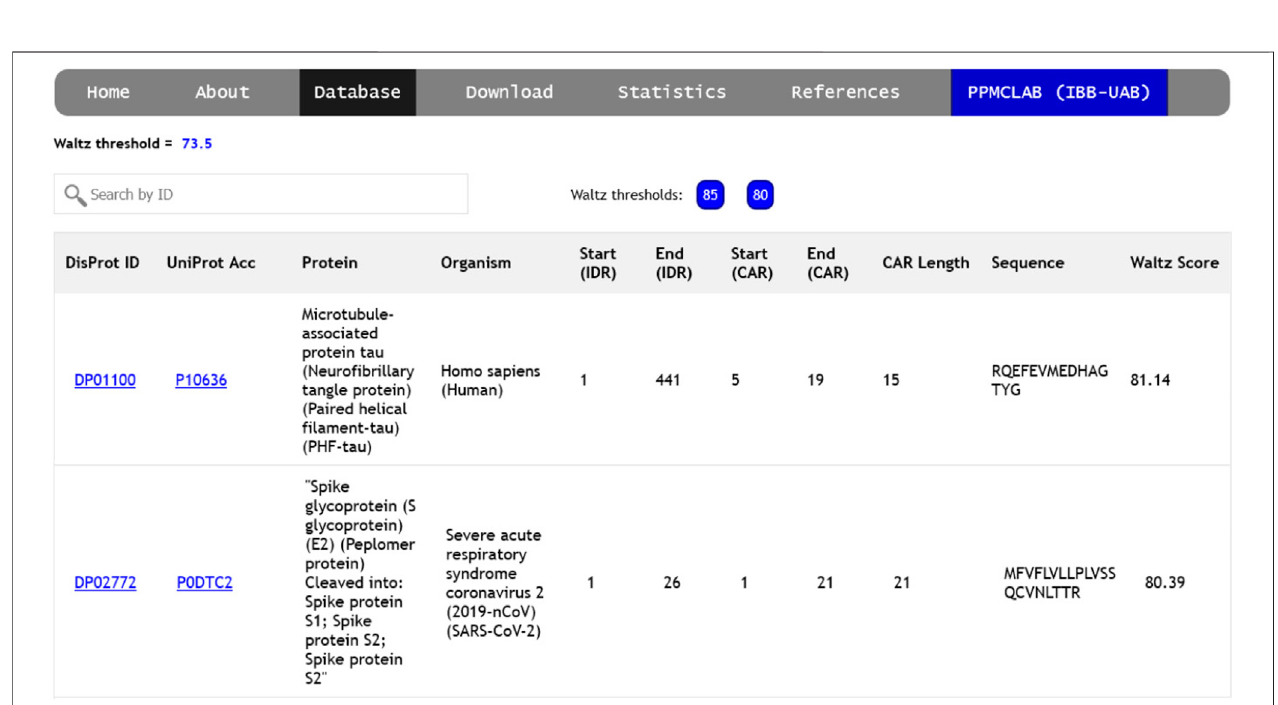
FIGURE2| Screenshotofthe ‘ Database ’ page.Thedifferentthresholds canbeexploredusingthe ‘ 85 ’ , ‘ 80 ’ and ‘ 73.5 ’ buttons foundnexttothesearchbar.Each CAR is a new entry with its associated DisProt ID, UniProt code and protein name, source organism, disorder position and the results for the amyloidogenic prediction (CAR position, length, sequence and score).